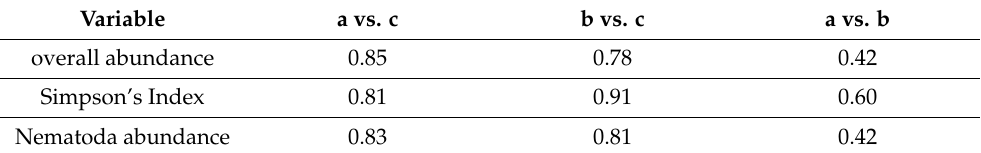
Figure 3. Distribution maps based on random forest regression using backscatter and bathymetry only (left), all available predictors (middle) and sediment and nodule parameters only (right) as predictor variables. Maps show overall meiofauna abundance ( a – c ), Simpson’s Index on high taxonomic level ( d – f ) and abundance of Nematoda ( g – i ). Table 4. Pairwise Pearson’s correlation of the spatial predictions based on random forest regression computed for overall meiofauna abundance, Simpson’s diversity index and abundance of the taxon Nematoda using backscatter and bathymetry only (a), sediment and nodule parameters only (b) or all available predictors (c) as predictor variables. All correlations are highly significant. Variable a vs. c b vs. c a vs. b overall abundance 0.85 Simpson’s Index 0.81 Nematoda abundance